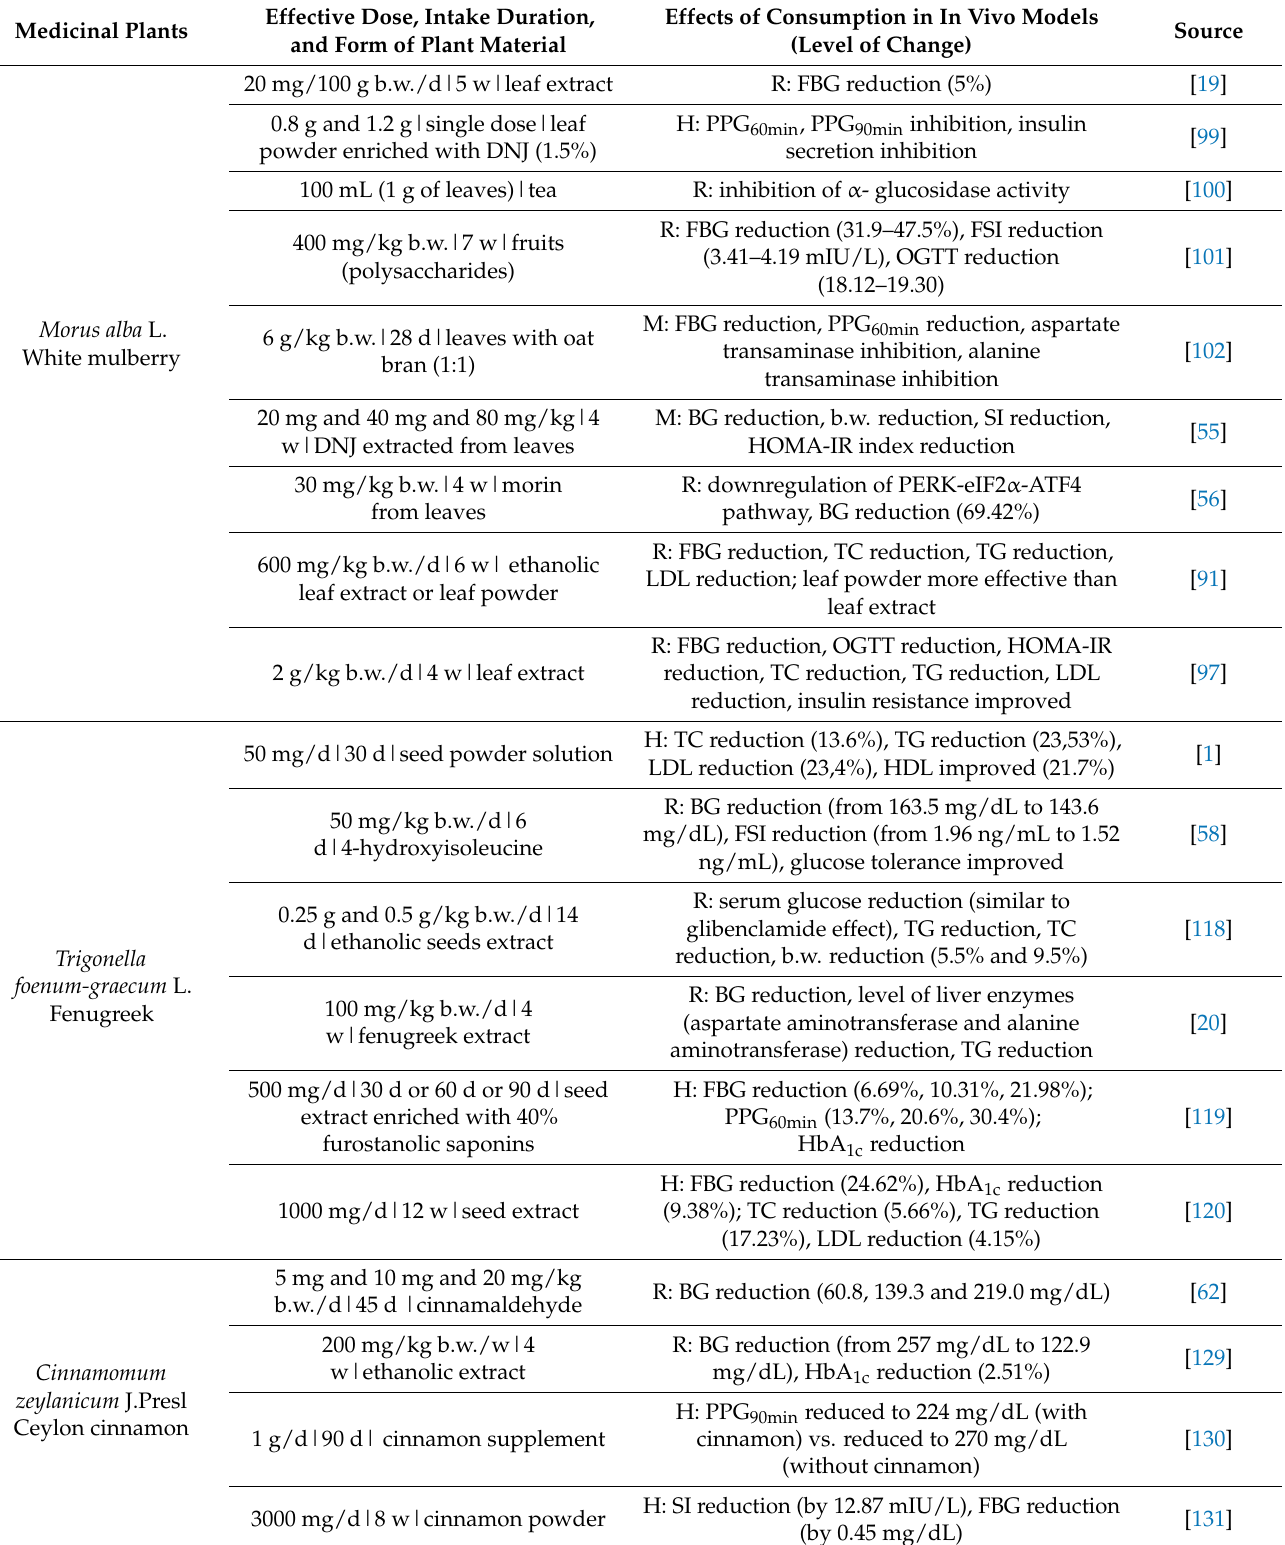
Table 3. Some studies considering medicinal plants, as described in this mini